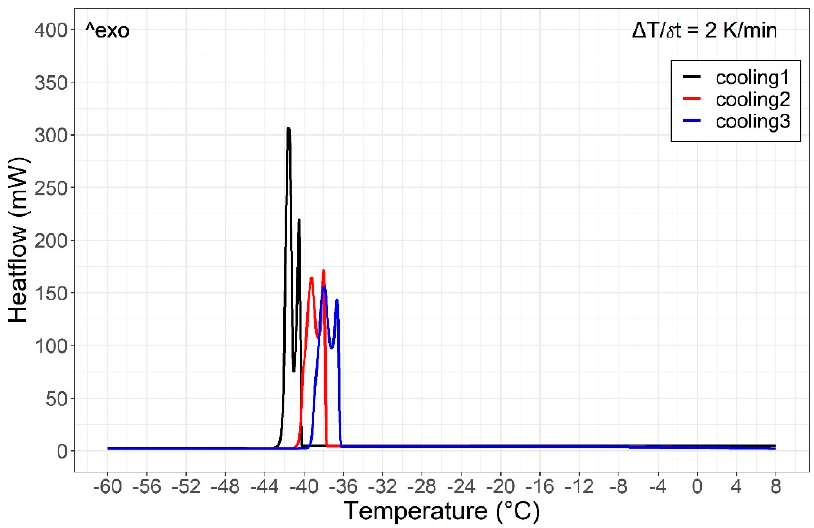
Figure 4. DSC cooling curves performed with 2 K/min for NaCl/water 23.3 wt.% revealing multiple crystallization peaks.